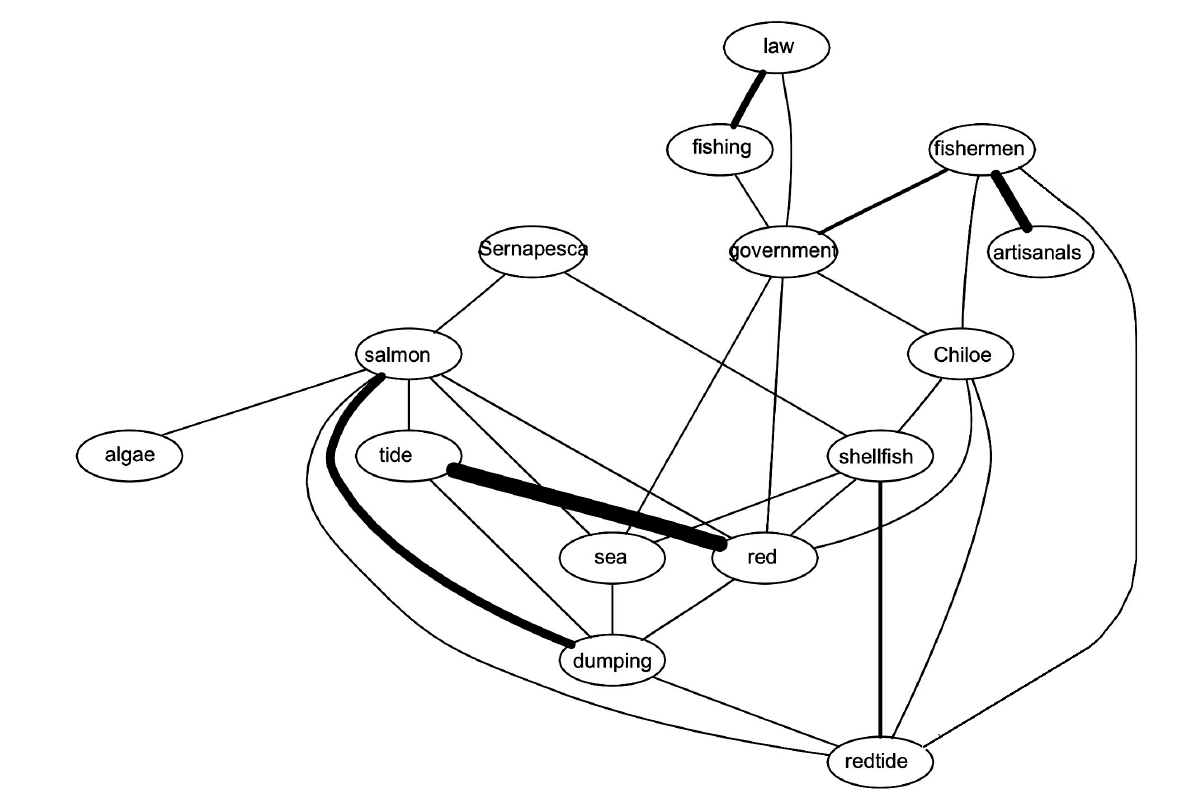
Fig. 4 . Main communication topics during the crisis: March to May